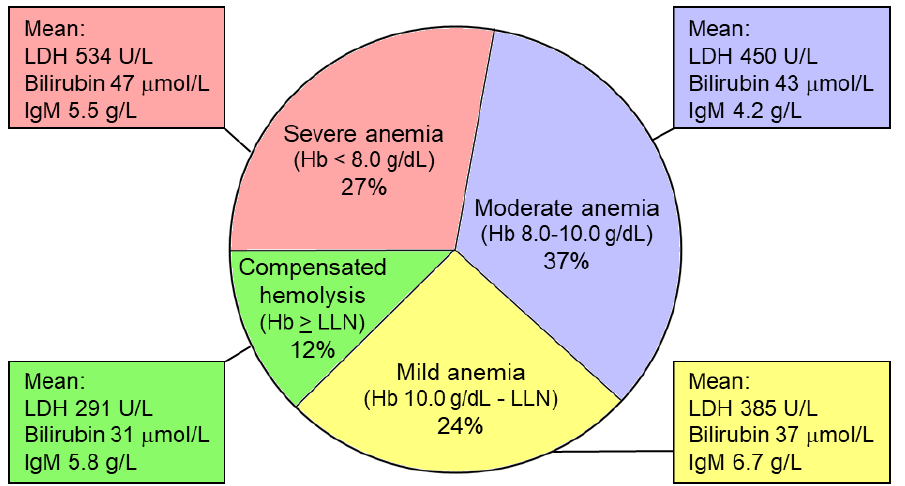
Figure 4. Severity of anemia in cold agglutinin disease; percentages of patients. Severity of anemia correlates nicely with markers of hemolysis (LDH and bilirubin levels), but not with IgM levels, as expected because of variable biologic activity of cold agglutinins. Hb, hemoglobin level; LDH, lactate dehydrogenase; LLN, lower limit of normal (Hb 11.5 g/dL in women and 12.5 g/dL in men). Based on data from Berentsen et al. [26]. Figure first published in Front Immunol 2019 [21], reused under a Creative Commons CC-BY license 4.0 (https://creativecommons.org/licenses/by/4.0/, accessed on 15 September 2022). © S. Berentsen.